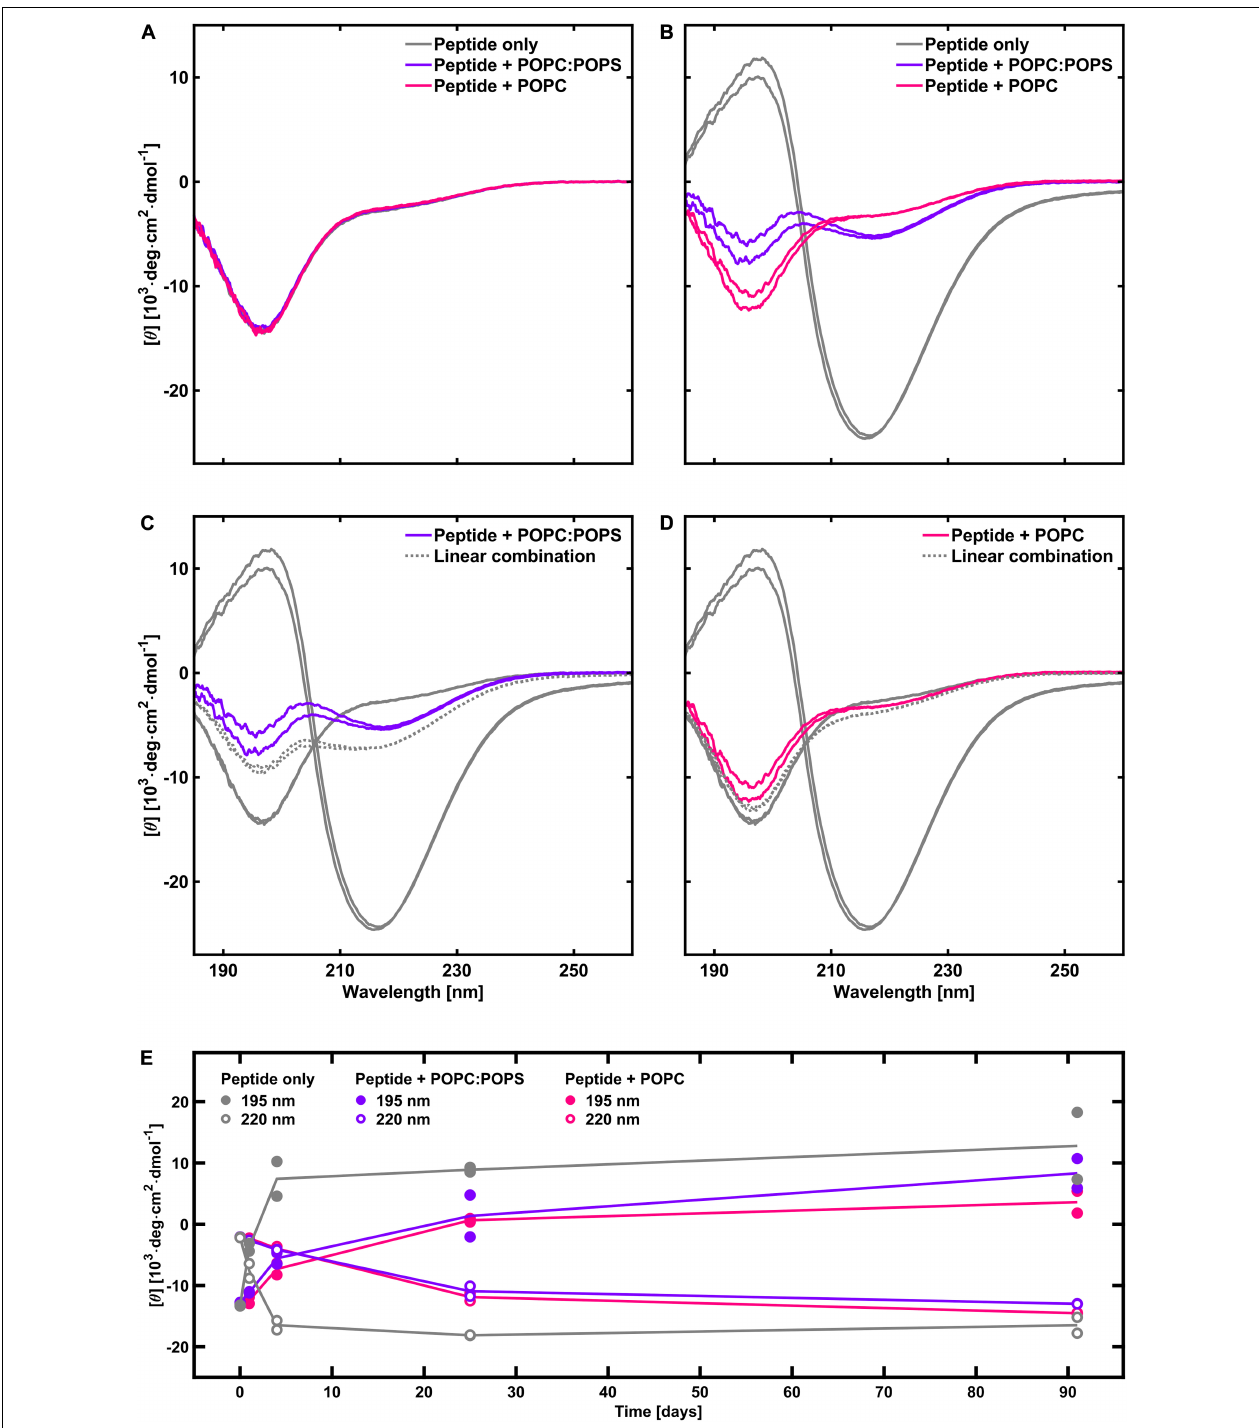
FIGURE 6 | CD spectra of peptide in the absence and presence of phospholipids, with duplicate samples for each system. (A) Initial time point. (B) After 1 day. (C) Estimation of the extent of fibrillation in the presence POPC:POPS (gray dotted line) relative to peptide fibrillated alone, based on a linear combination of the spectra for peptide alone at t = 0 and at t = 1 day (80% of the spectrum at t = 0 plus 20% of the spectrum at t = 1 day). (D) Same as (C) but with POPC instead of POPC:POPS. The linear combination shows 95% of the peptide alone spectrum at t = 0 plus 5% of the spectrum at t = 1 day. (E) Time evolution of the CD intensity at 195 and 220 nm, with and without phospholipid vesicles (based on a different peptide batch). It shows that the fibrillation continues to increase after 1 day in the presence of phospholipids. Phospholipids thus have an inhibiting effect on the rate of fibrillation.